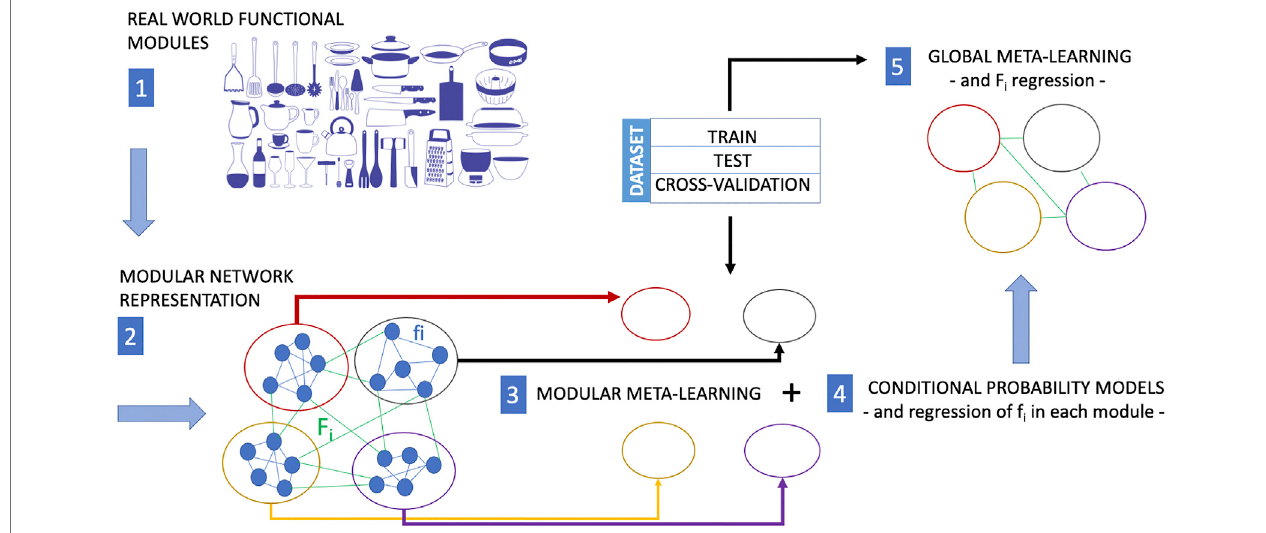
FIGURE 2 | In many situations, training experience is very expensive. While meta-learning is a strategy to reduce the training-data requirements for a new task, modular meta-learning is a strategy to reduce or save computational resources. Modular meta-learning methods learn sets of network modules of a biological network. This learning scheme aims at mimicking the animal brain which is capable to factor out variations of a context or a task, and by virtue of this ability it does not need to implement different algorithms in separate anatomical regions to learn each single variation of a context or task. The functional modularity of a real system (here represented as a collection kitchen utensils with different functions) is fi rst mapped into a modular network (each module of which performs a different function). The causal structure of processes within each module can be learned by modular meta-learning methods, and fi nally the causal structure of the interactions among network clusters is learned by meta-learning approaches including regression of the functions f i internal to each modules (modular meta-learning) and then of the F i representing the cross-talksbetweenclusters(global meta-learning). The image ofthe kitchen utensilsin this fi gure ispart ofthe Pixabay freeonlinepictures